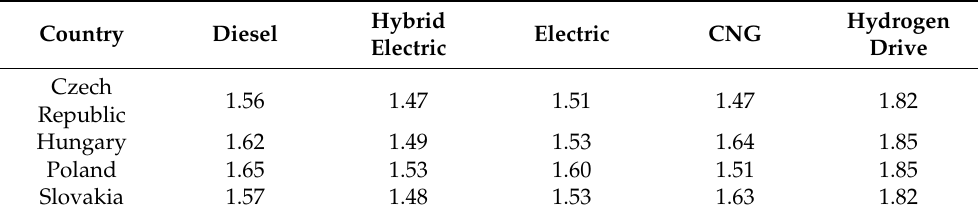
Figure 3. The structure of costs of implementing and operating buses, by type of drive on the example of maxi (12 m) buses in the Czech Republic; Source: own study. Table 9. Cost of vehicle-kilometer maxi buses (12 m) with different drive types in the V4 countries for the entire period of vehicle operation ( € ).